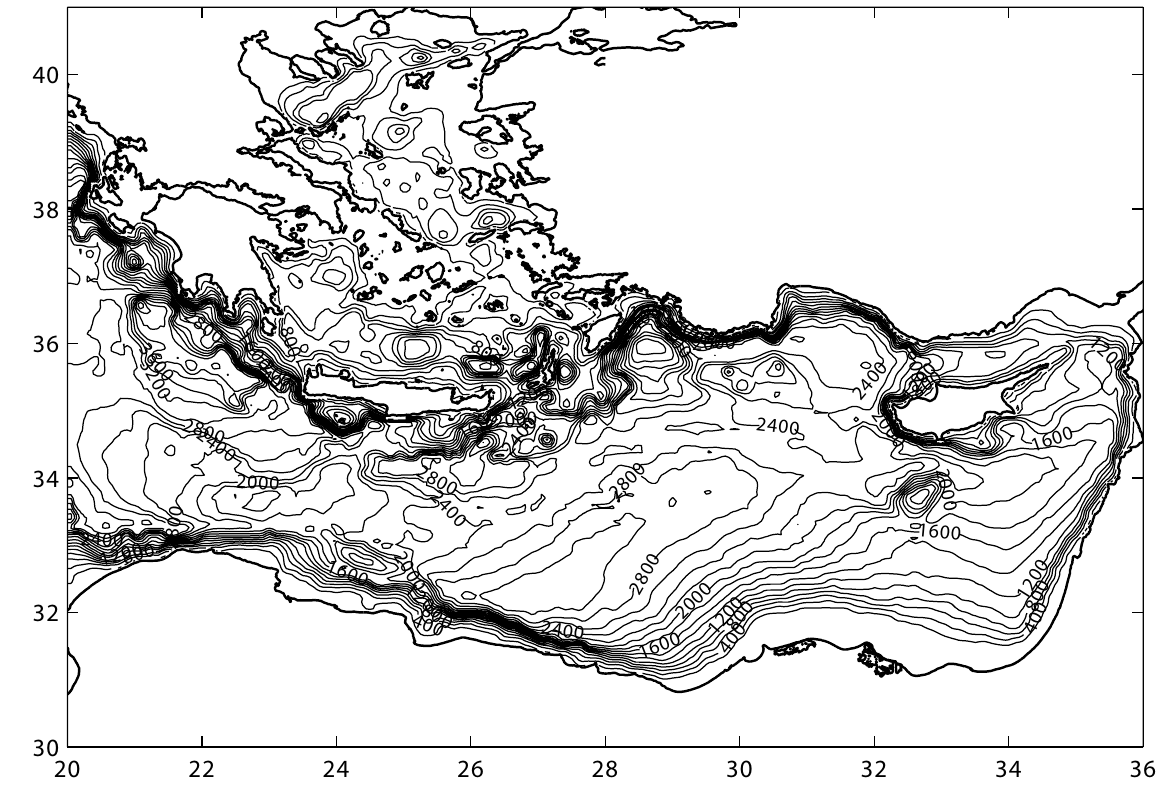
Fig. 6. ALERMO model topography in meters (contour interval: